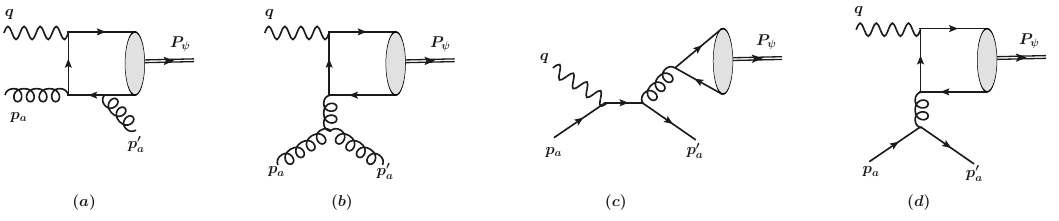
Figure 2 . Representative diagrams of the partonic subprocesses contributing to J/ψ production in SIDIS at the order αα 2 , γ ∗ ( q ) + a ( p a ) → J/ψ ( P ψ ) + a ( p 0 ) with a = g, q, ¯ q . The six diagrams s a of type (a) are the only ones corresponding to the CS production mechanism. Moreover, there are two diagrams for each type (b), (c),